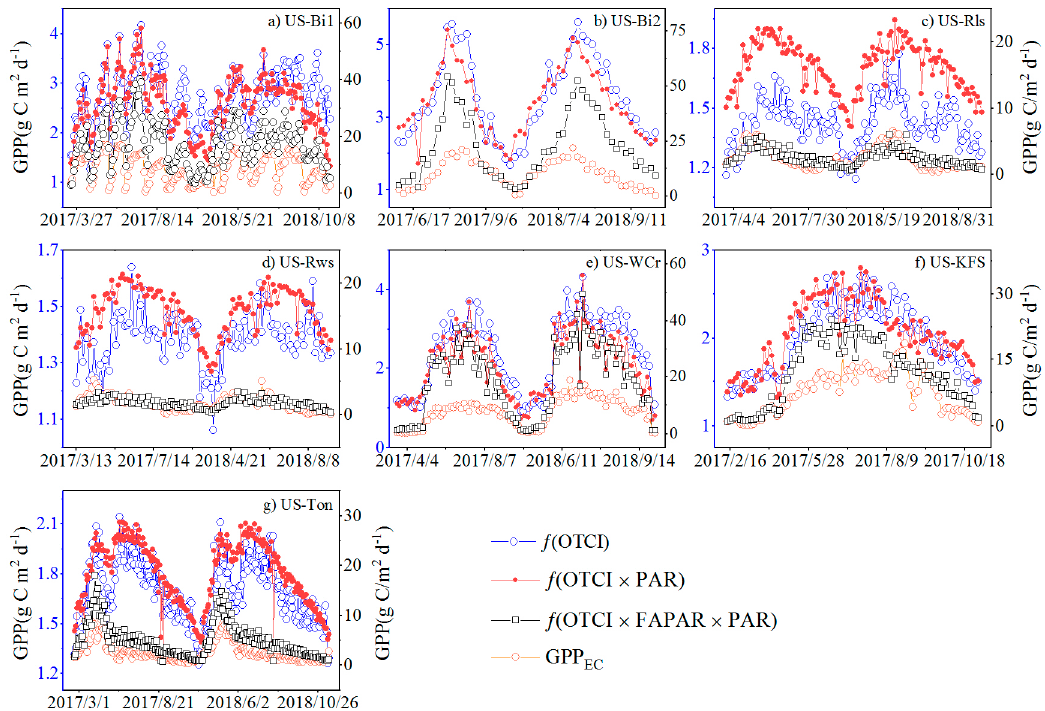
Figure 7. Temporal dynamics of GPP EC and three OTCI-driven GPP OTCI for all sites in 2017 and 2018.